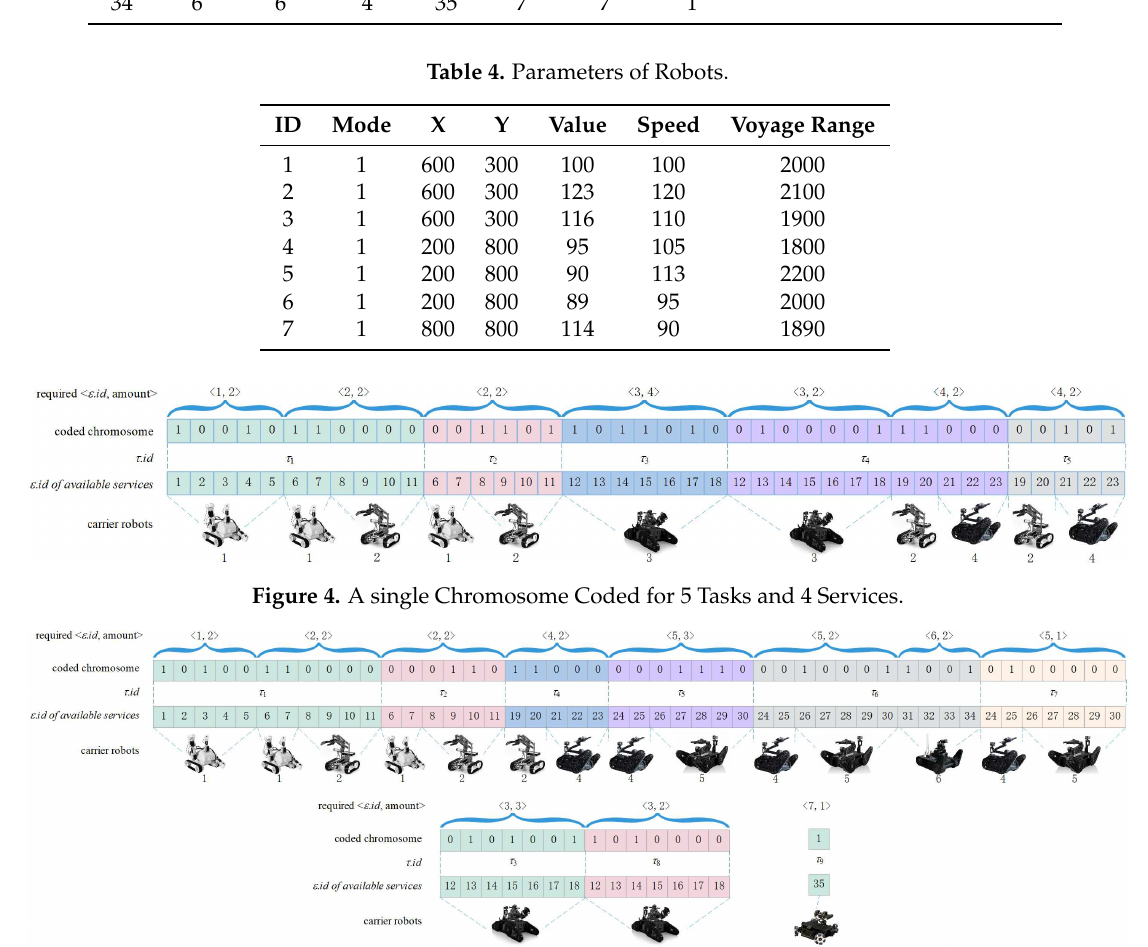
Table 4. Parameters of Robots.